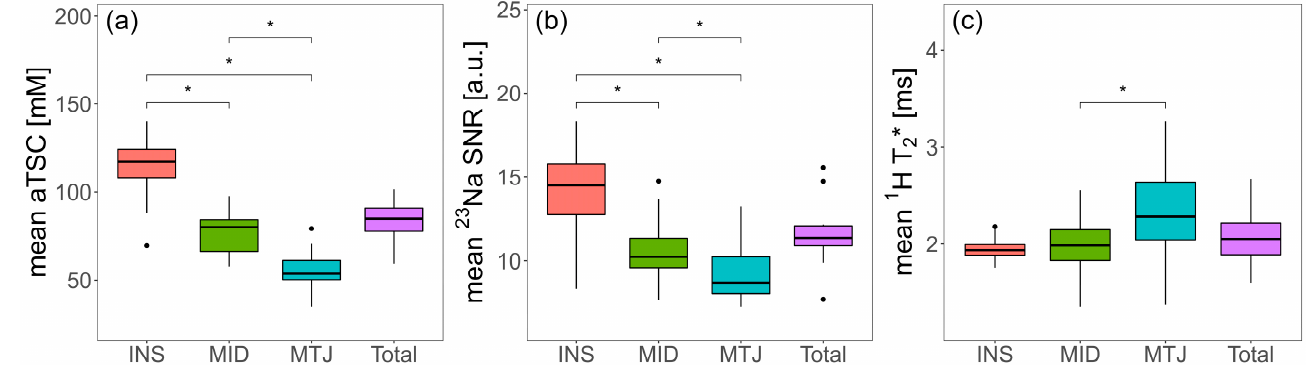
Figure 5. Boxplots illustrating the results for healthy controls for ( a ) aTSC, ( b ) 23 Na SNR and ( c ) 1 H T 2 * for the AT ROIs INS, MID, MTJ and the total ROI, which is the combination of the previous three. The parentheses above the boxplots indicate whether the difference between the groups was significant (*) in the Bonferroni corrected Wilcoxon rank-sum tests with a significance level of p ≤ 0.05.